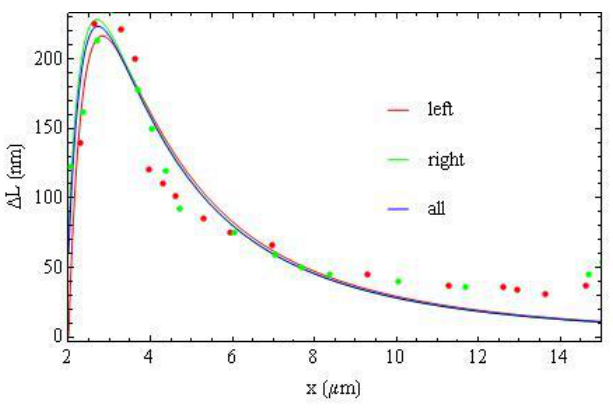
Figure 18. Fitting the left part (red), right part (green) and all experimental data (blue) with Equation (20) with m = 3 and m = 5 results in almost the same interpolation curves.